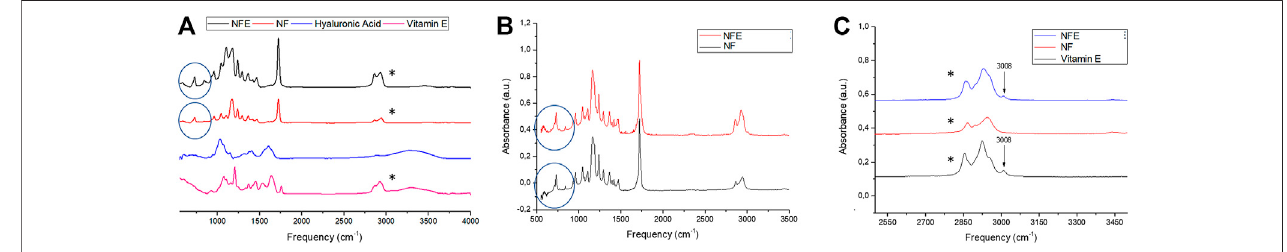
FIGURE 2 | Micrographs at SEM of the three-dimensional structure of NF (A) and NFE (B) , showing the width of the pores among fi bers and fi bers organization. SEM observation revealed that NFE appeared more swollen than NF. Nano fi ber ’ s diameter distributions are reported for NF (C) and NFE (D) samples.